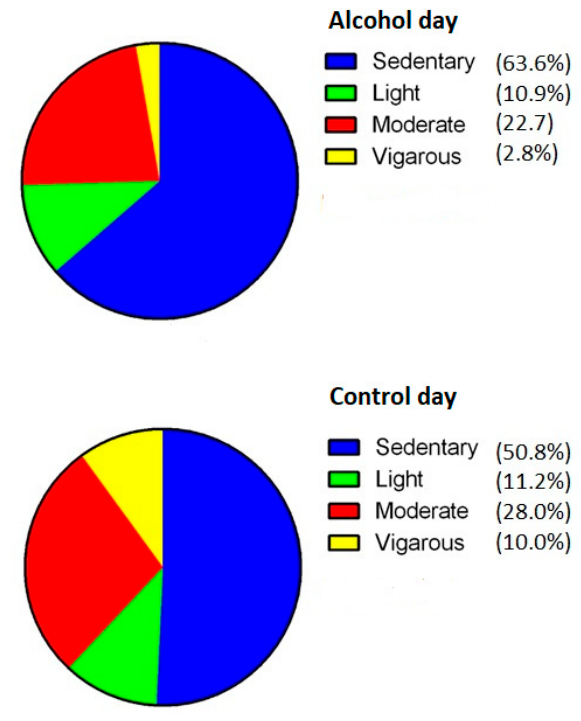
Figure 3. Percentage spent engaging in sedentary, light, moderate and vigorous activity on the alcohol day and control day.